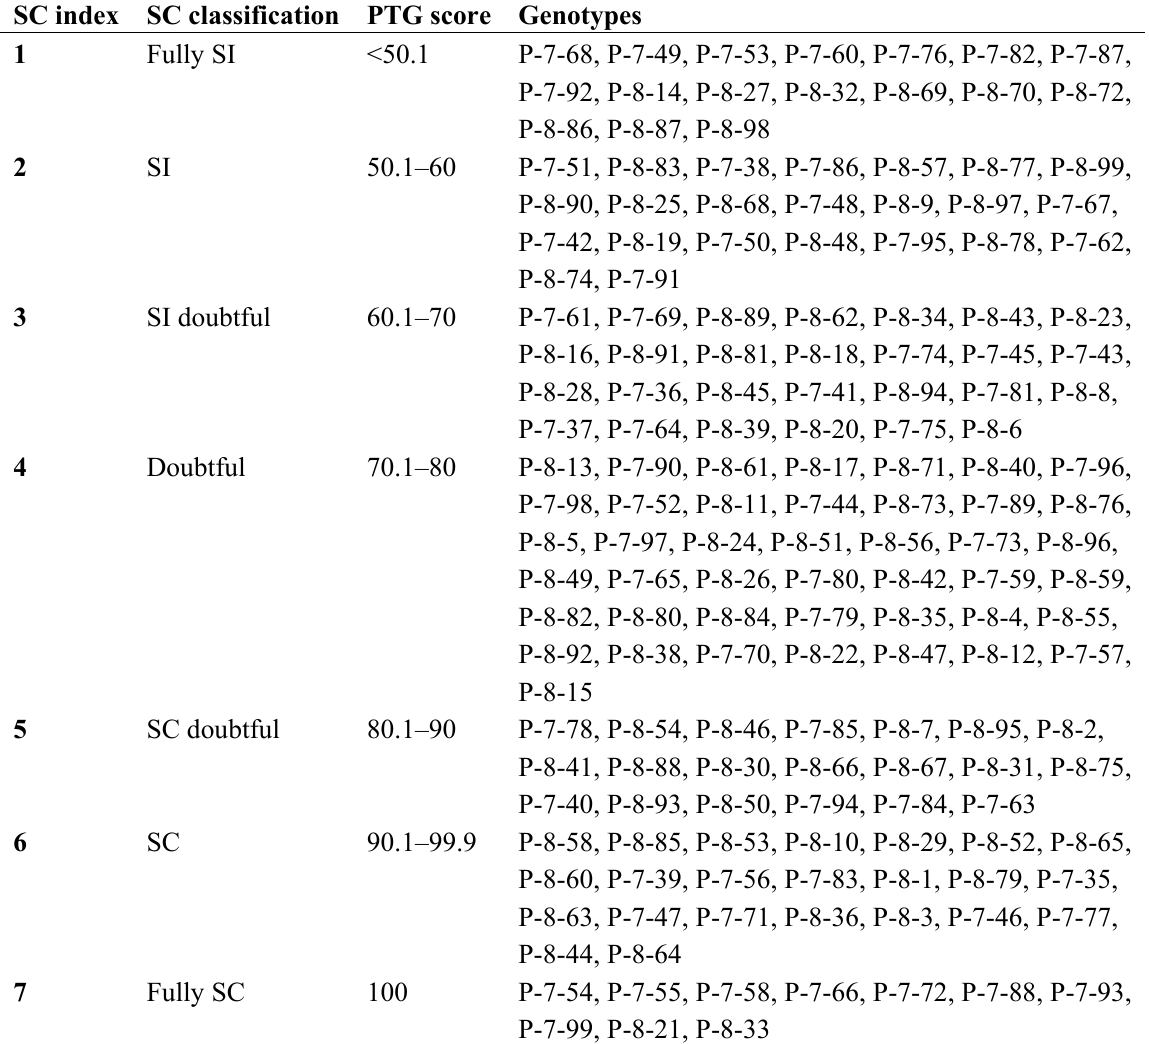
Table 1. Seedling classification in SC indices of the offspring from the almond cross G-4-3 × “Marcona” according to their PTG